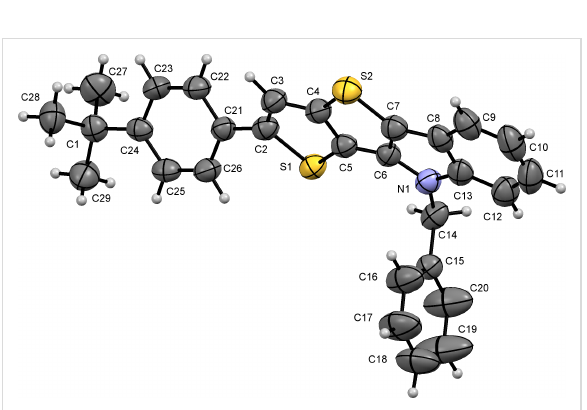
Figure 2: ORTEP diagram for the X-ray structure of compound 7d . Thermal ellipsoids of 50% probability are